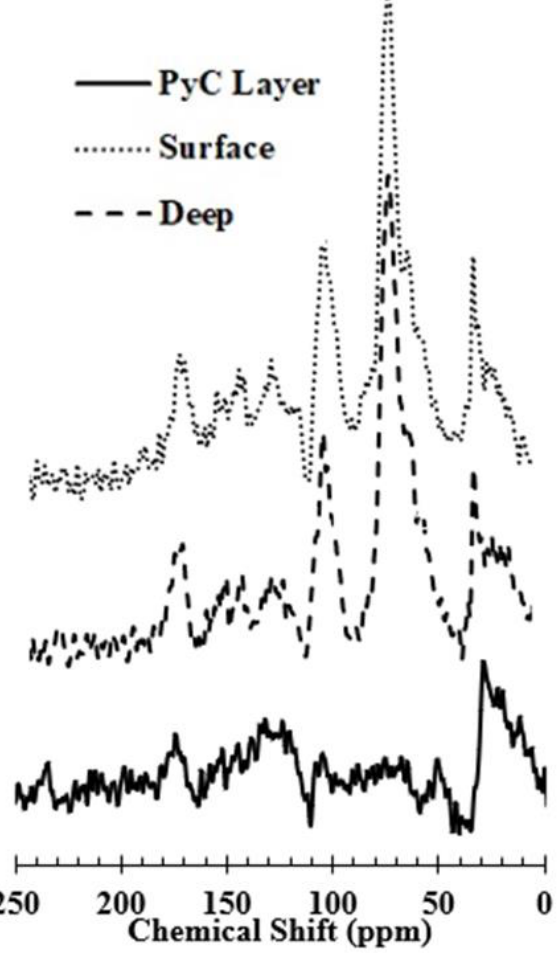
Figure 3. A comparison of direct polarisation NMR spectra representing three endmembers, surficial Sphagnum peat, deep Sphagnum peat, and pyrogenic carbon for illustrative